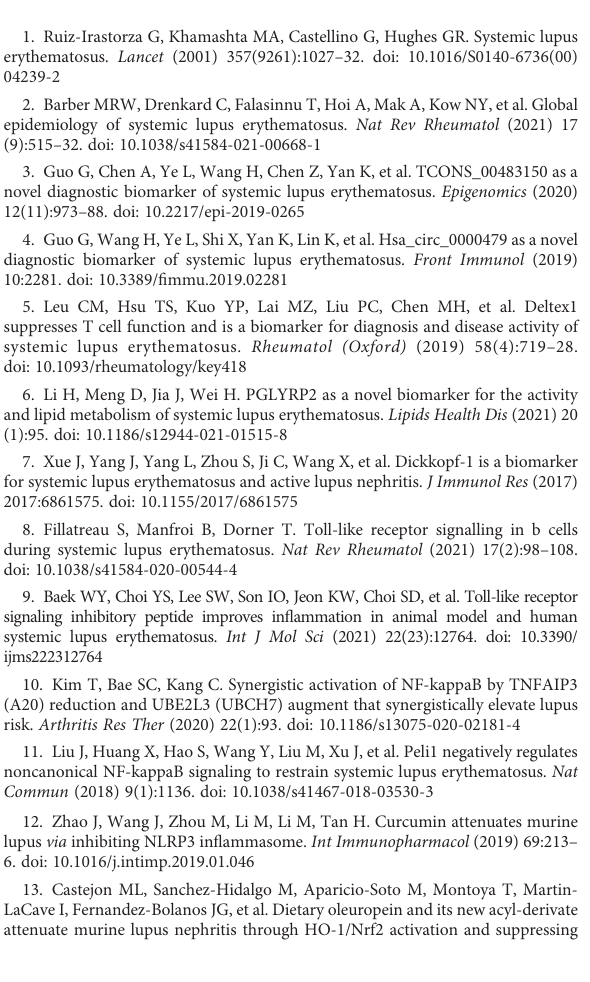
and immune cells. SUPPLEMENTARY FIGURE 7:1 The UMAP plot in the GEO datasets. SUPPLEMENTARY FIGURE 7:2 The sample clustering map of GSE121239. SUPPLEMENTARY FIGURE 7:3 (A) enrichGO analysis results of MX2. (B) gseGO analysis results of MX2. (C) enrichKEGGpathwayanalysisresultsofMX2. (D) GSEAanalysisresultsofMX2. SUPPLEMENTARY FIGURE 7:4 (A) , (B) Correlation between MX2 and NOD-like receptor signaling pathway genes. (C) Intersection of pathway genes with high correlation with MX2. (D) Correlation between MX2 and NOD-like receptor signaling pathway scores. (E) Comparison of the distribution of NOD-like receptor